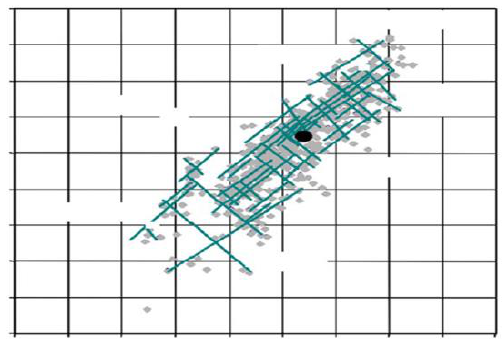
Figure 2. The shape of network fracture [26].